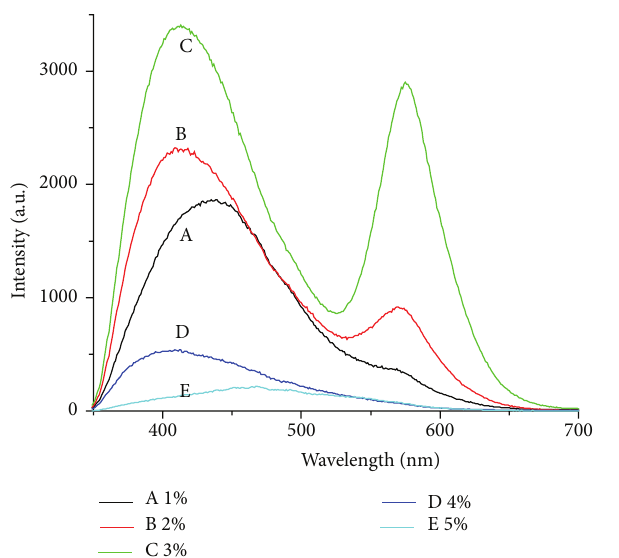
Figure 5: Fluorescence emission spectra of ZnS:Mn 2+ QDs under the different pH value of an aqueous solution (from 10.5 to 12.5), obtained using an excitation wavelength of 300